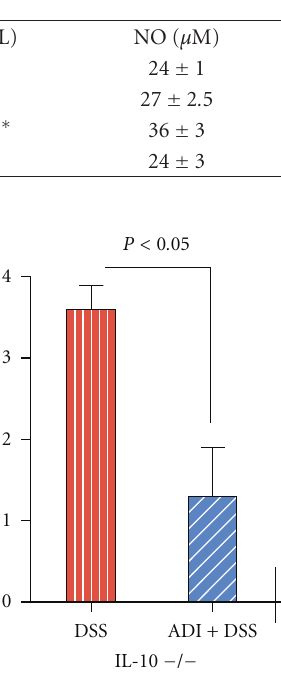
ff ect of ADI-PEG on histopathology scores (0– 4) according to the severity of lesions in DSS-colitic